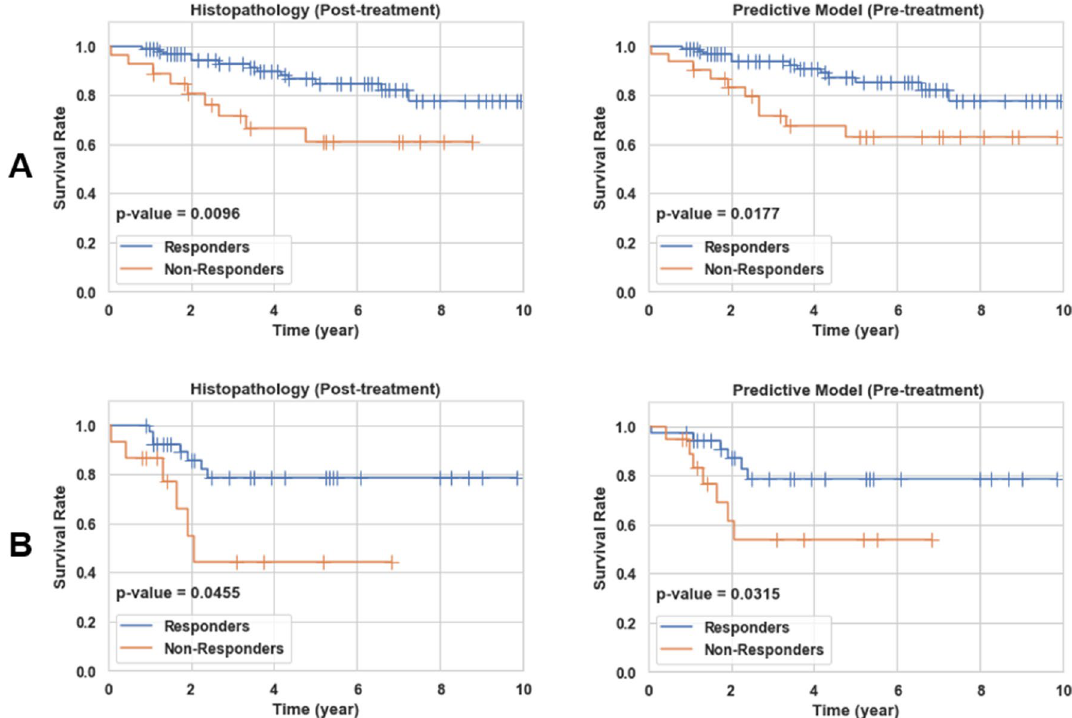
Figure 6. Ten-year recurrence-free survival curves for responding and non-responding patients in the training ( A ) and independent test set ( B ) identified at post treatment based on the clinical and histopathological criteria, and at pre-treatment using the developed predictive model with the optimal QUS